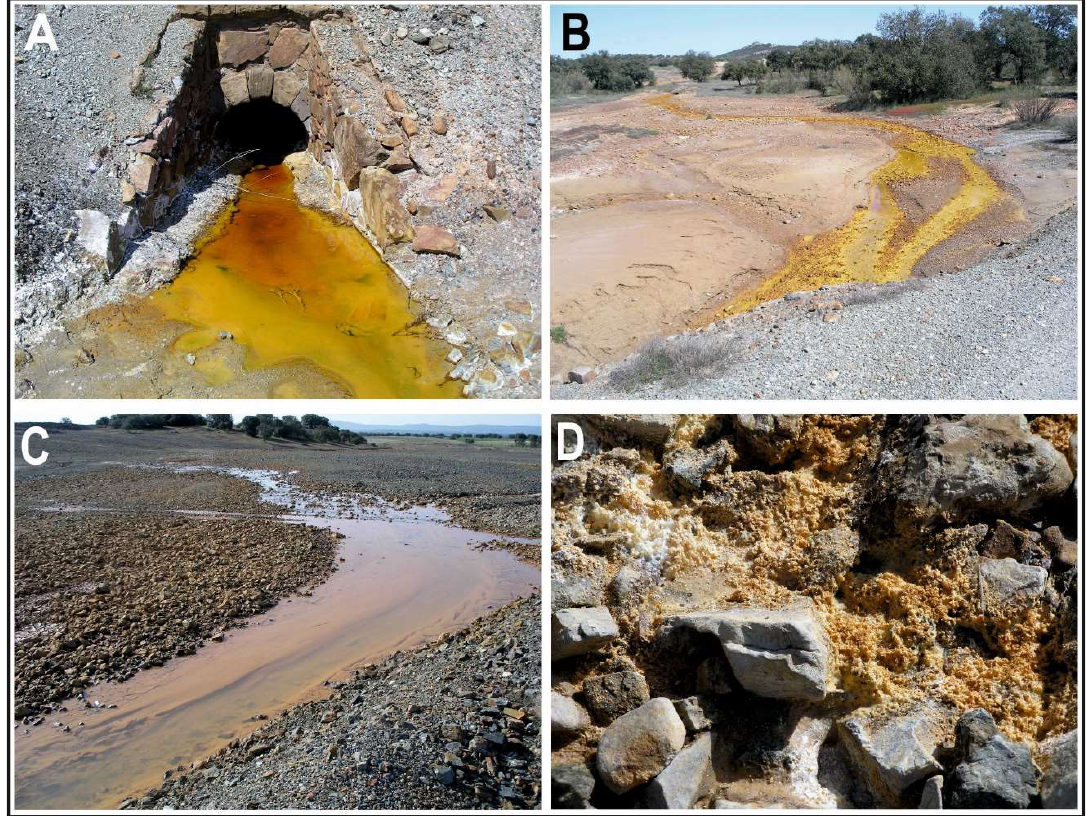
Figure 3. Acid mine drainage from San Quintín East ( A , B ) and near neutral mine drainage from San Quintín West ( C , D ).